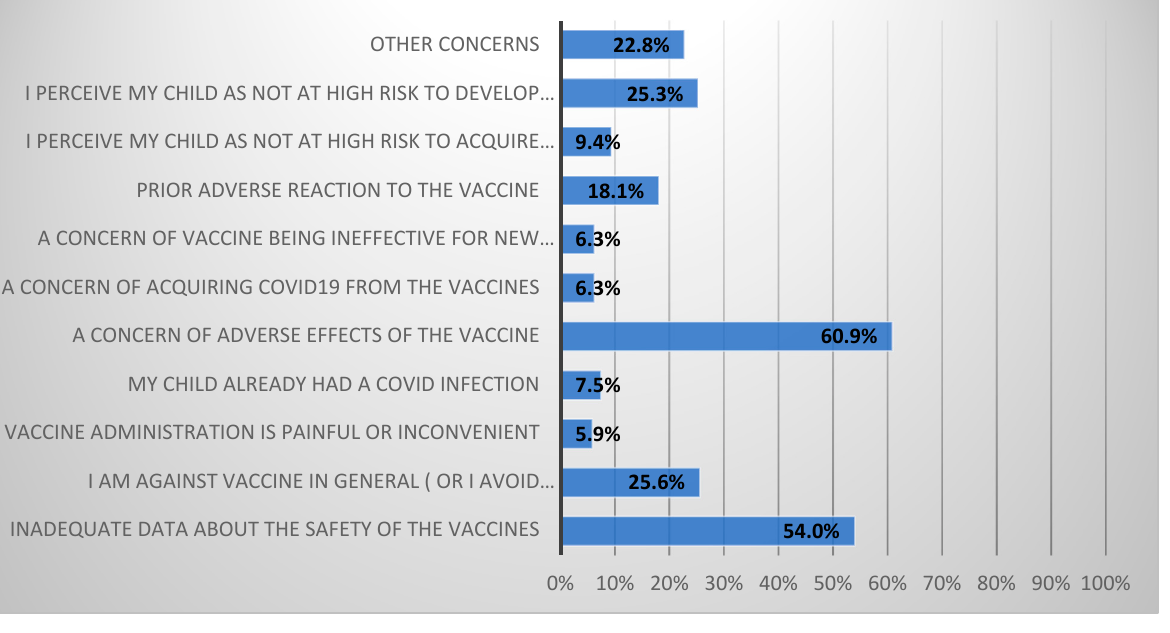
Figure A3. Parents’ reasoning of sending their teenager to school if COVID case reported in other classes.